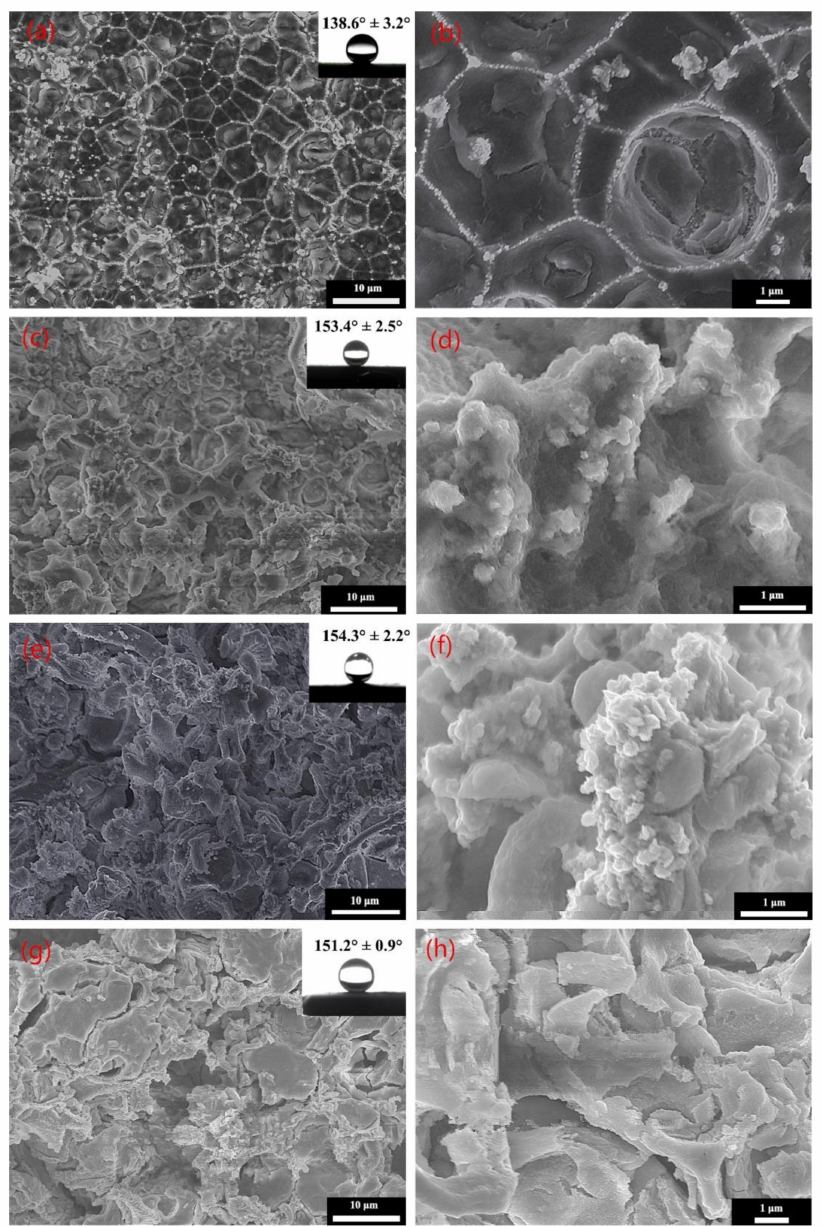
Figure 1. SEM images of the sample surfaces at different processing times: ( a , b ) 2 min, ( c , d ) 7 min, ( e , f ) 15 min, and ( g , h ) 22